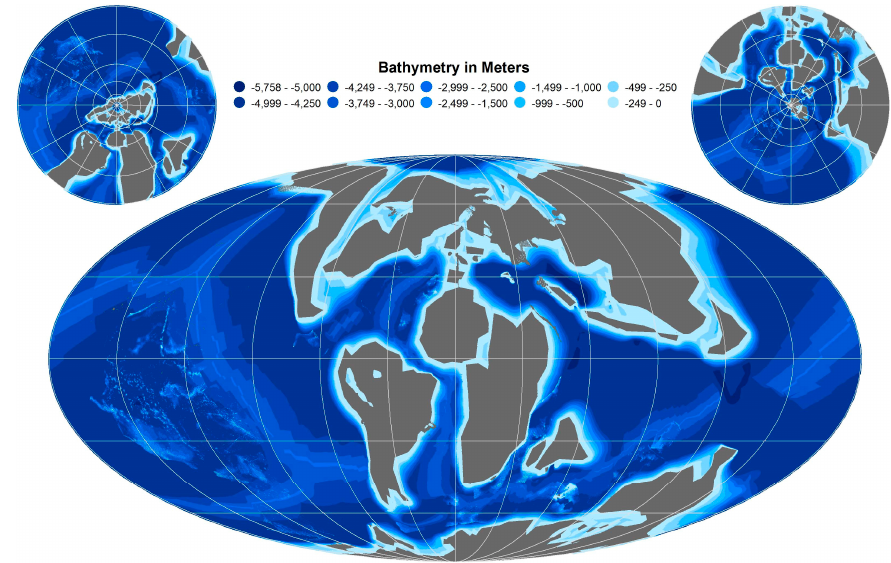
Figure 8. Interpolated 94 Ma reconstructed bathymetry with isostatically adjusted, multicomponent sediment layer, continental shelf-slope-rise structures, and known LIPs and